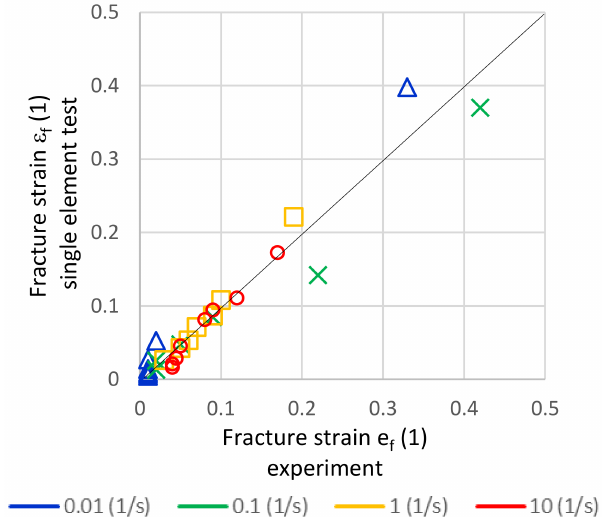
Figure 8. Comparison between fracture strain of the model versus experiments.